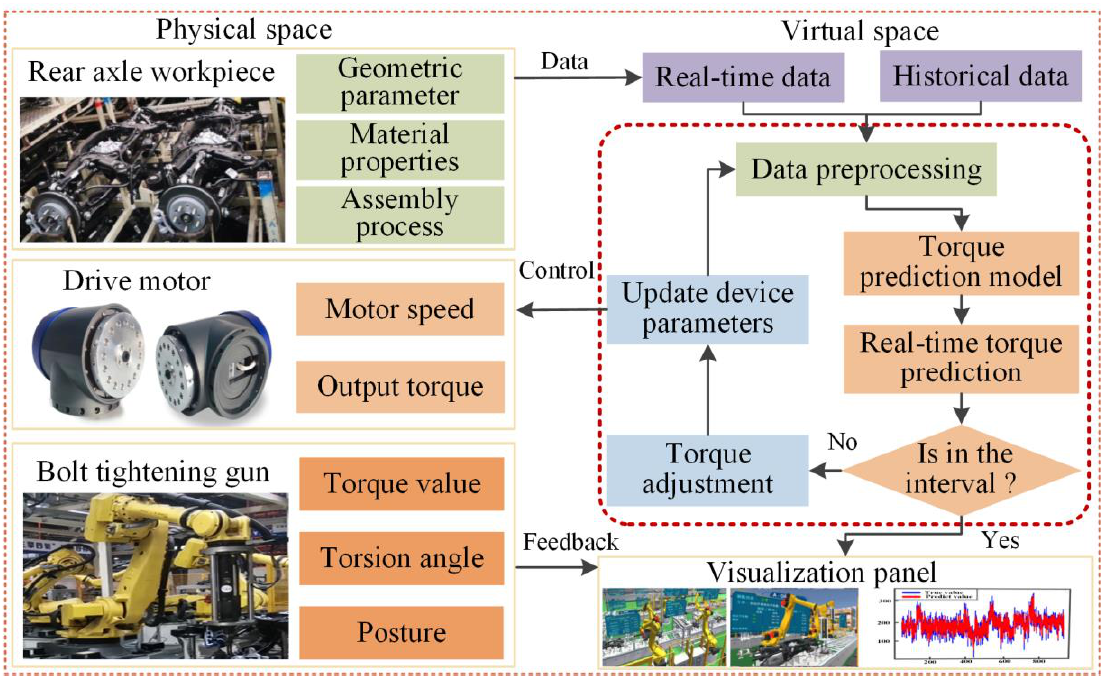
Figure 13. Online torque control based on digital twin assembly.